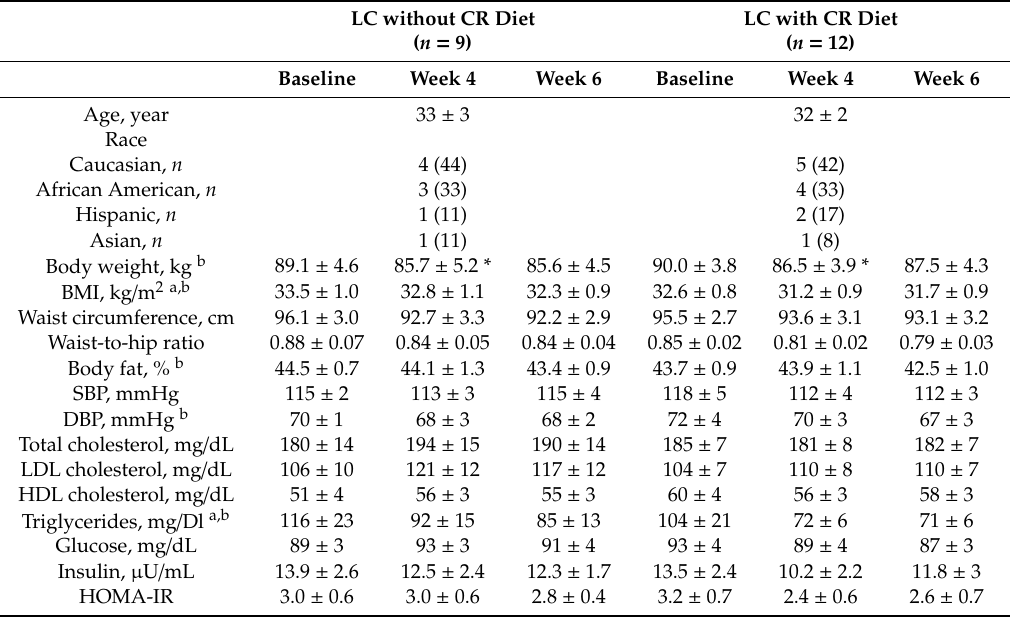
Glucose, mg / dL Insulin, µ U / mL